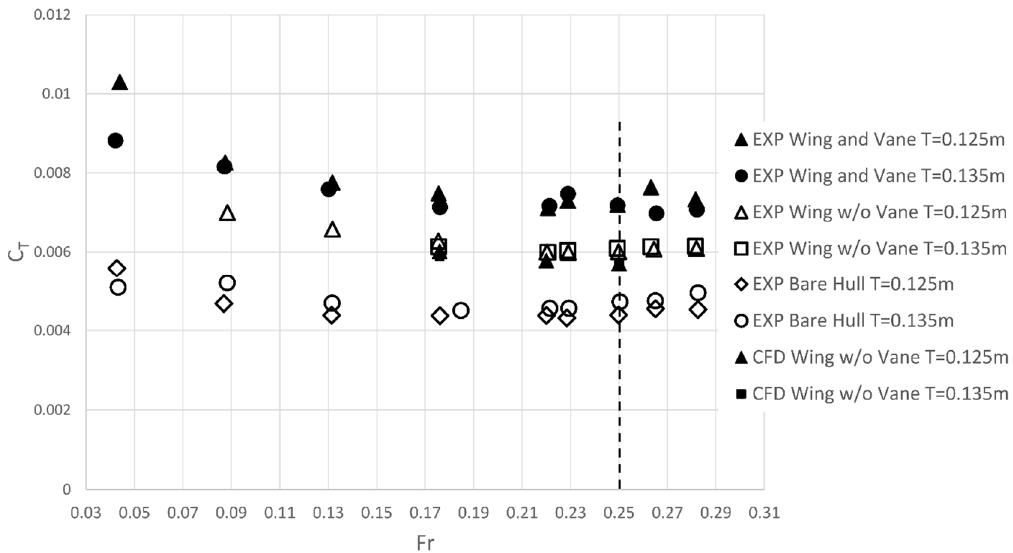
Figure 8. Calm water resistance coefficient without and with the flapping thruster for various model speeds and corresponding Froude numbers, and for the two drafts. The Froude number corresponding to design ship speed (Fr = 0.25) is indicated by using a dashed line.